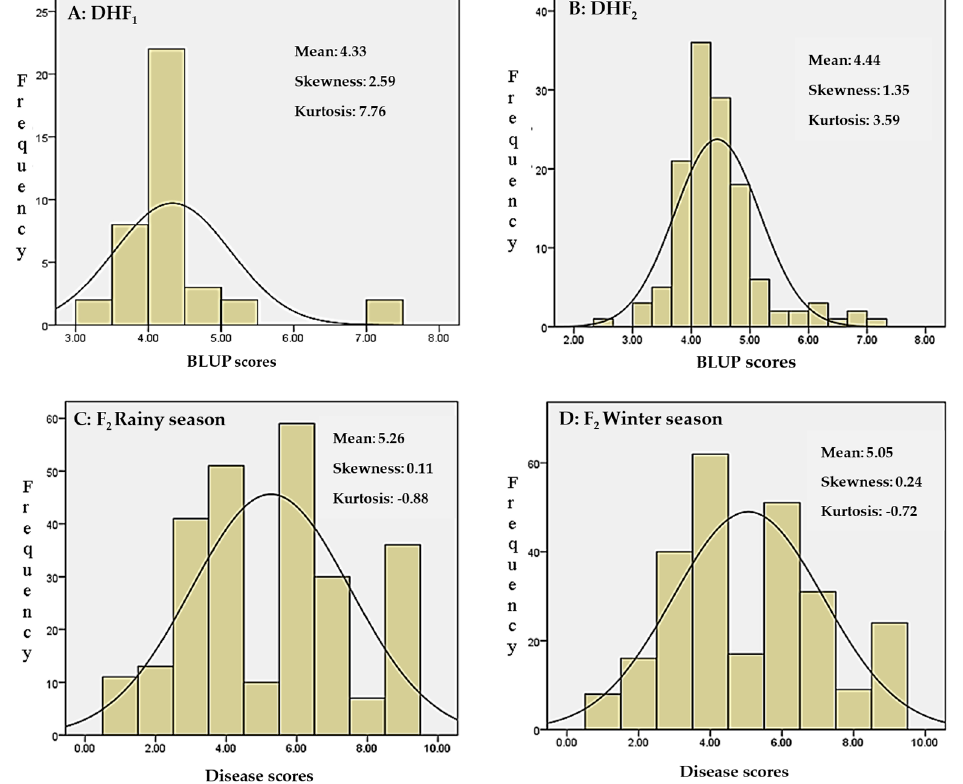
Figure 4. Frequency distribution for FSR disease response in DHF 1 , DHF 2 , and F 2 plants of the cross VL121096 × CM202 ( A ), DHF 1 lines ( B ), DHF 2 lines ( C ), F 2 plants during rainy season ( D ), F 2 plants during winter season.